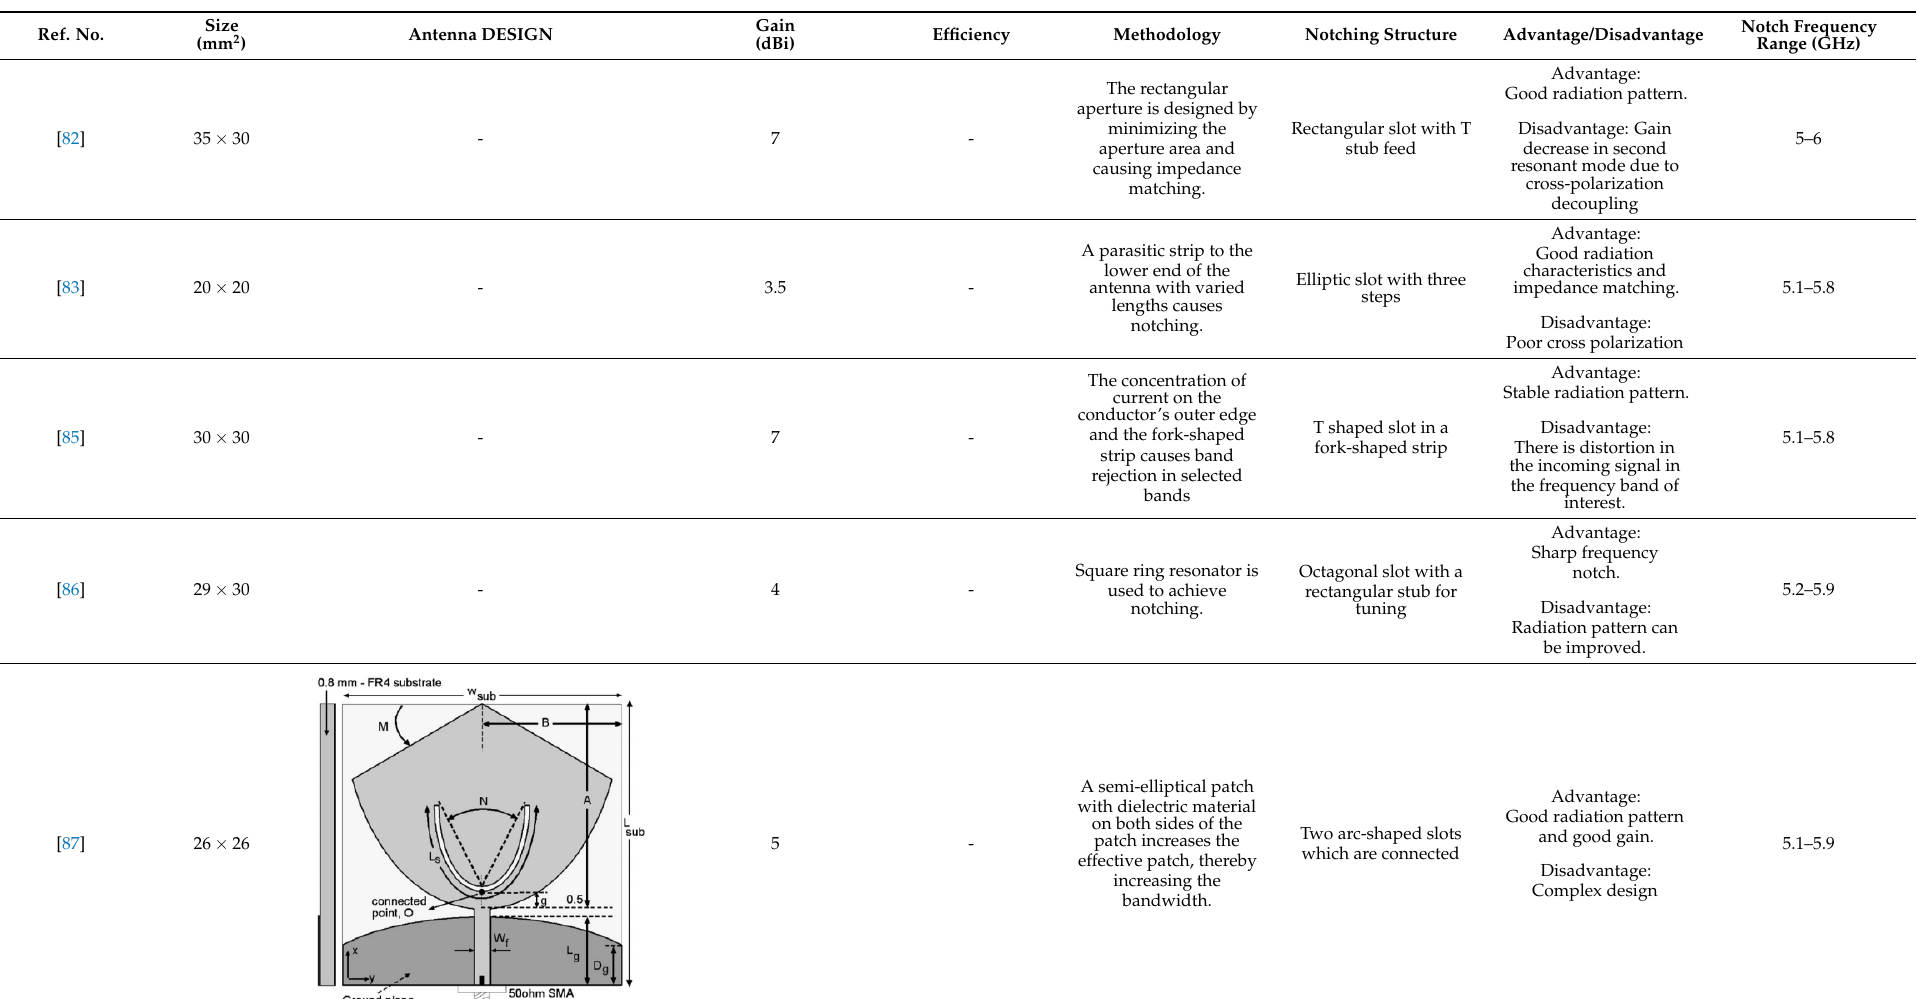
Table 3. The emergence of design of UWB notch